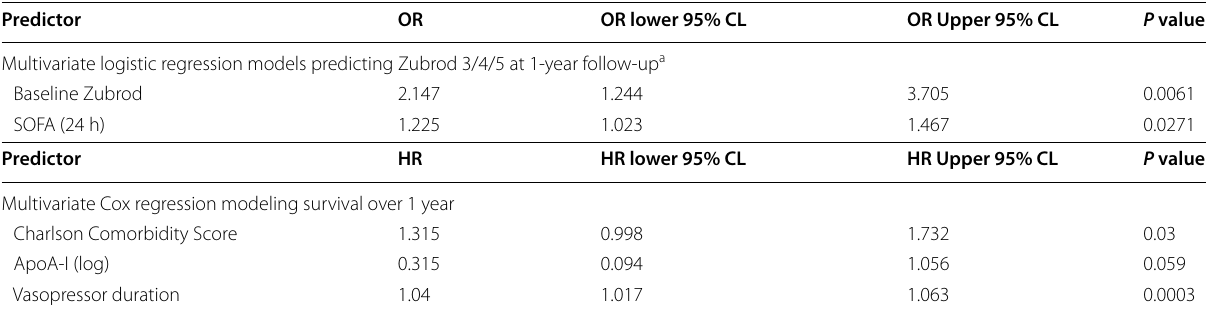
Table 5 Prediction models for Zubrod 3/4/5 and 1-year